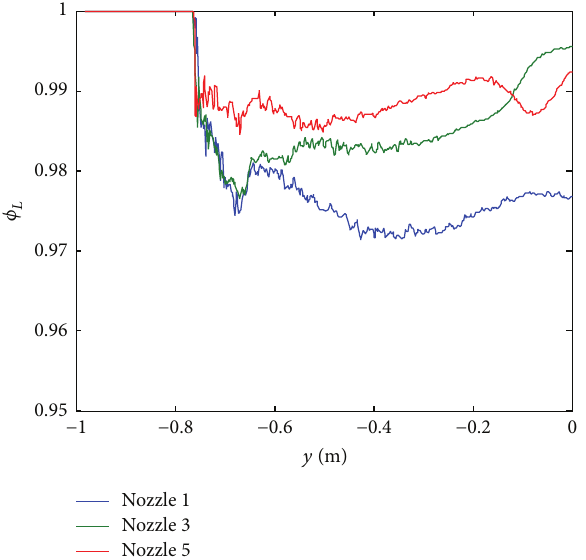
Figure 6: Plot of the volume fraction of liquid.